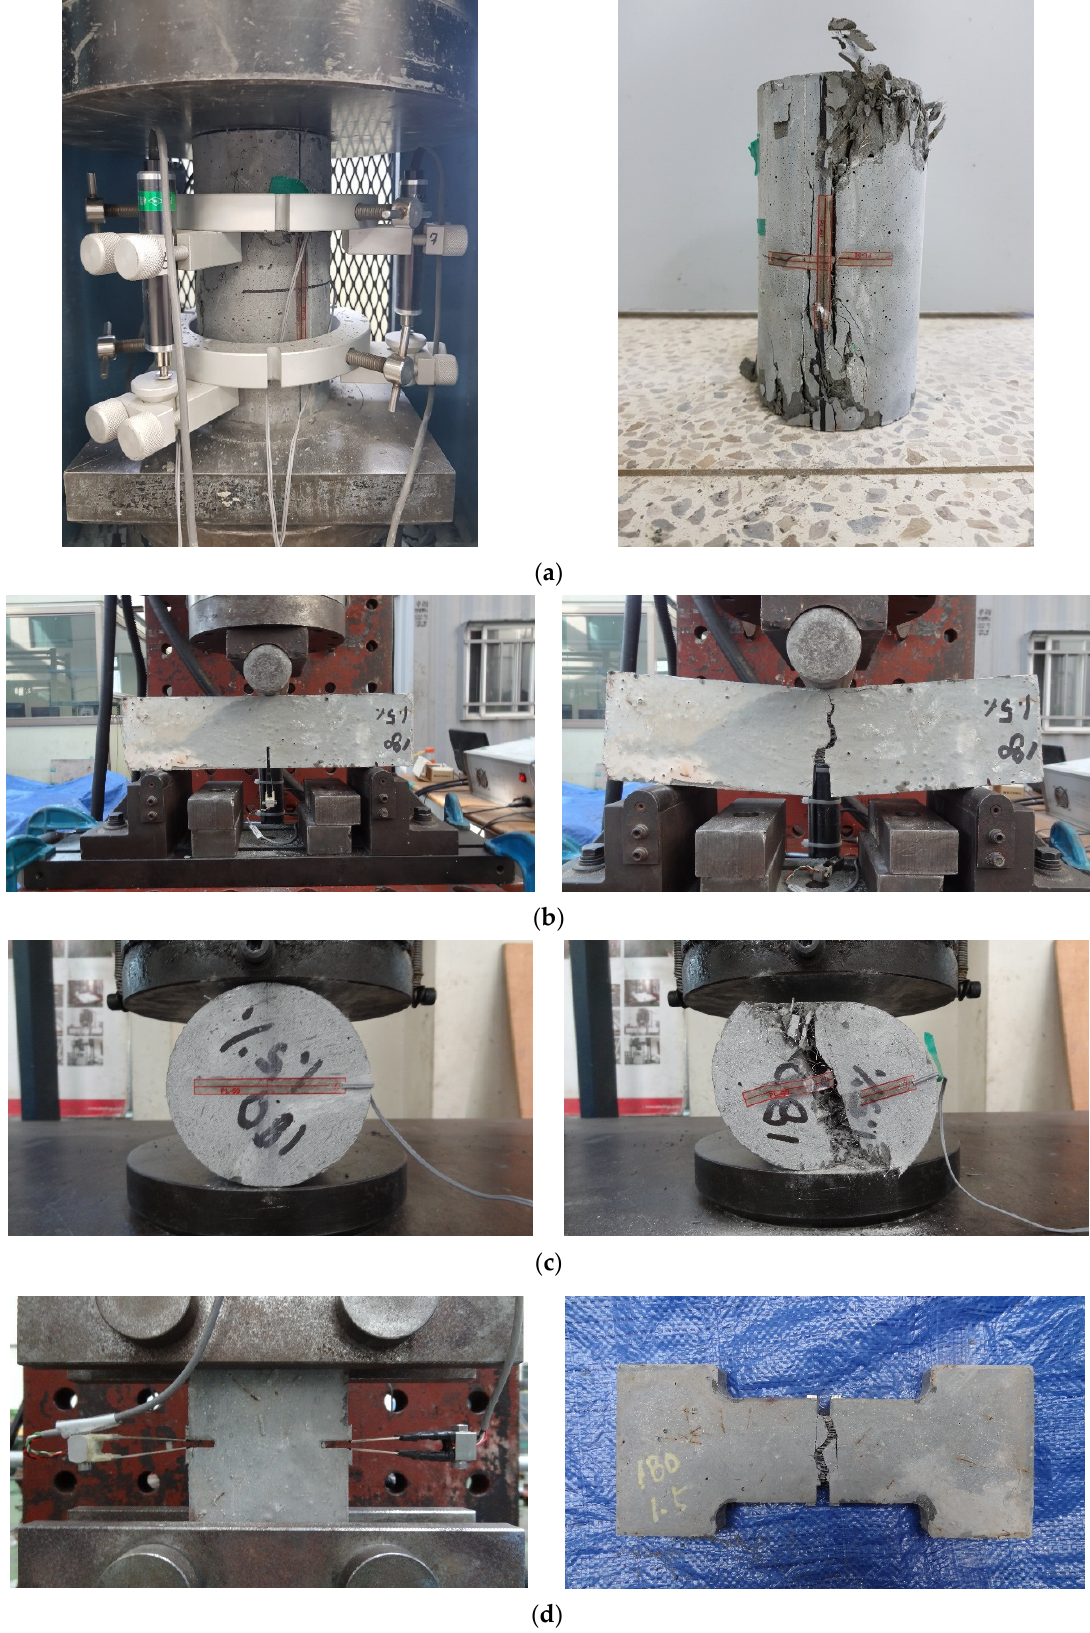
Figure 3. Material test setup and typical failure of material test specimens: ( a ) Compressive strength test; ( b ) Flexural strength test; ( c ) Splitting strength test; ( d ) Direct tensile strength test.